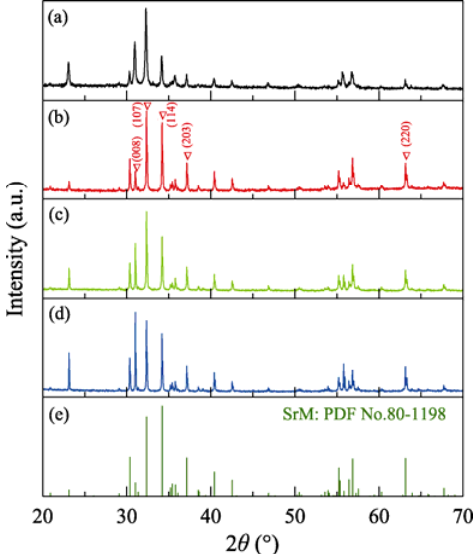
Fig. 1 XRD patterns of different SrM specimens: (a) as-pressed, (b) T s = 1100 ℃ , (c) T s = 1150 ℃ , (d) T s = 1250 ℃ , and (e) standard